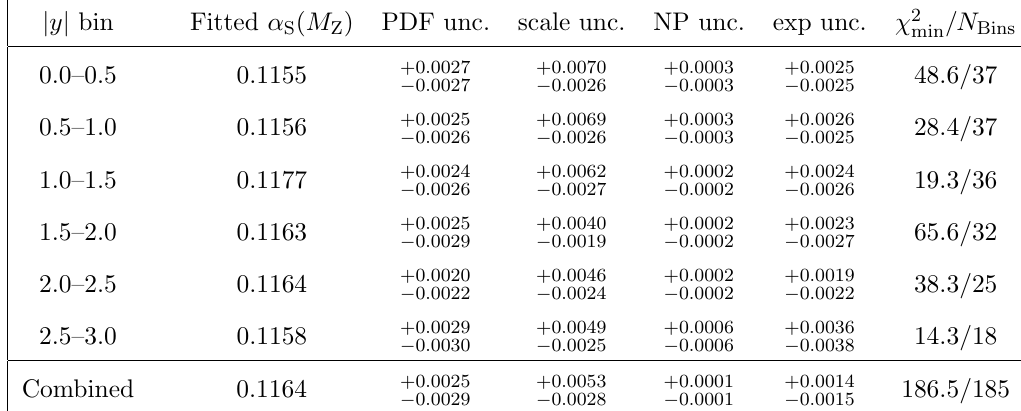
Table 4 . Results for (cid:11) S ( M Z ) extracted using the CT10 NLO PDF set. The (cid:12)tted value for each j y j bin; the corresponding uncertainty components due to PDF, scale, and nonperturbative corrections; and the total experimental uncertainty is shown. The last row of the table shows the results of combined (cid:12)tting of all the j y j bins simultaneously.